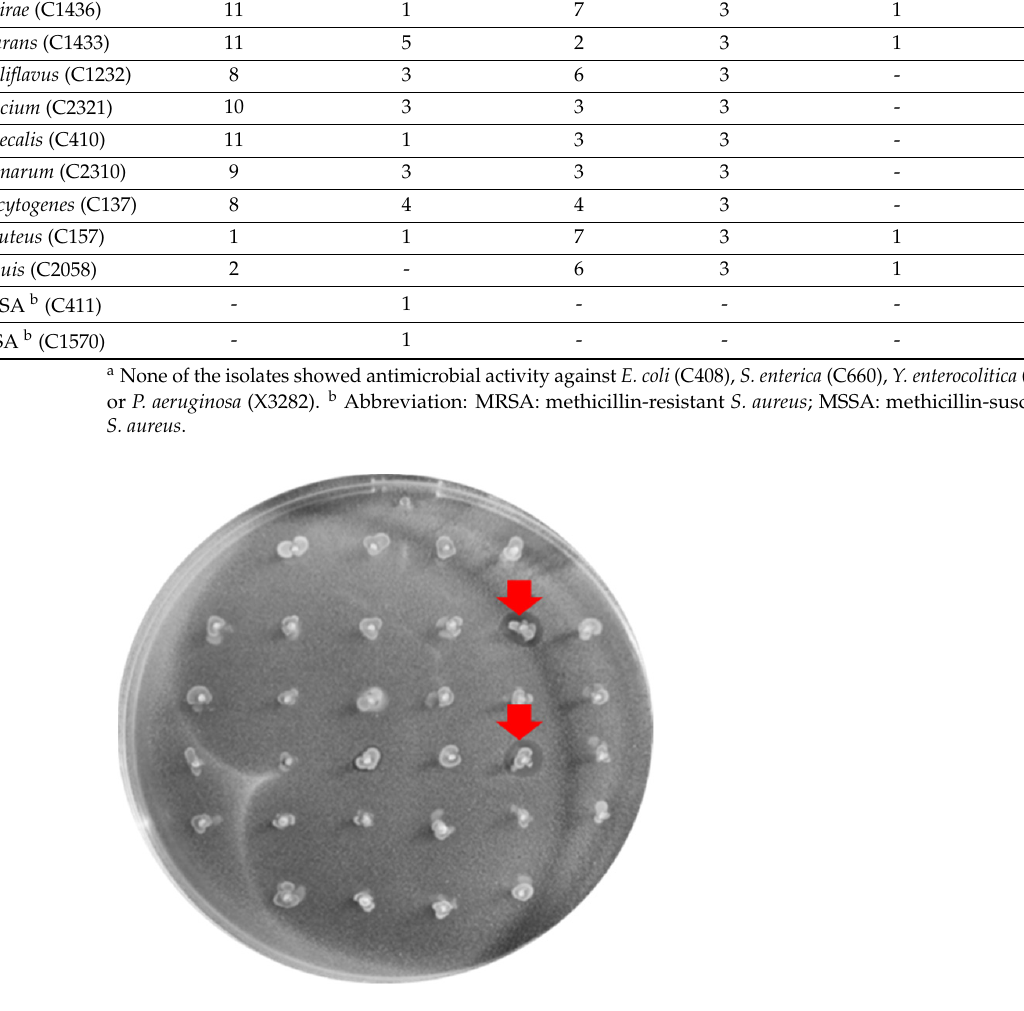
Table 1. Antimicrobial activity of the 32 bacteriocin producer (BP+) enterococci against C. perfringens X2967 and other relevant indicator bacteria a , as detected by the “spot on the lawn” assay. Number of BP+ Strains with Activity against the Indicator Strain E. faecium ( n = 11)